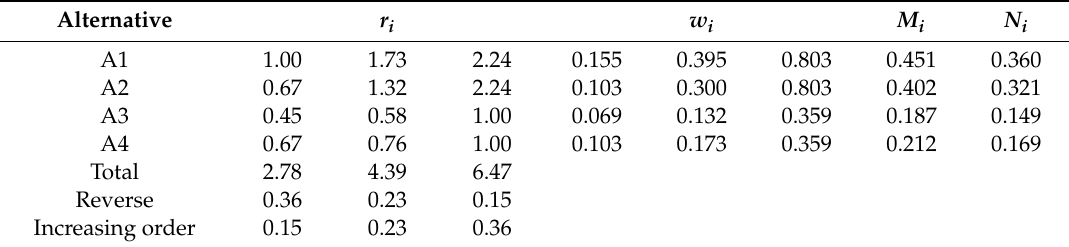
Table 20. Results of r i , W i , M i and N i in respect to the mitigation time.